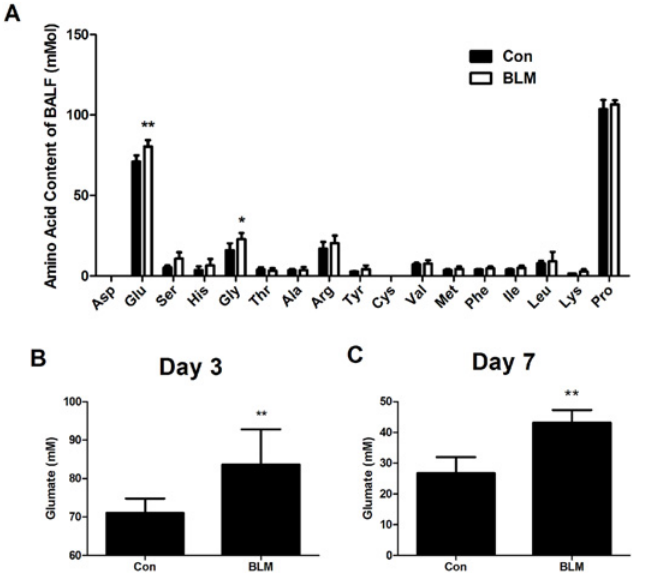
Fig 1. Concentrations of 17 kinds of amino acid and glutamate in BALF after BLM-induced injury. Lungs were lavaged and BALF was analyzed for 17 kinds of amino acid concentrations (A) and glutamate concentration at 3days (B) and 7days (C) after BLM instilled. n = 5 – 10. Bars: mean ± SD. ** P < 0.01 vs Con group. The experiment was repeated three times in the same